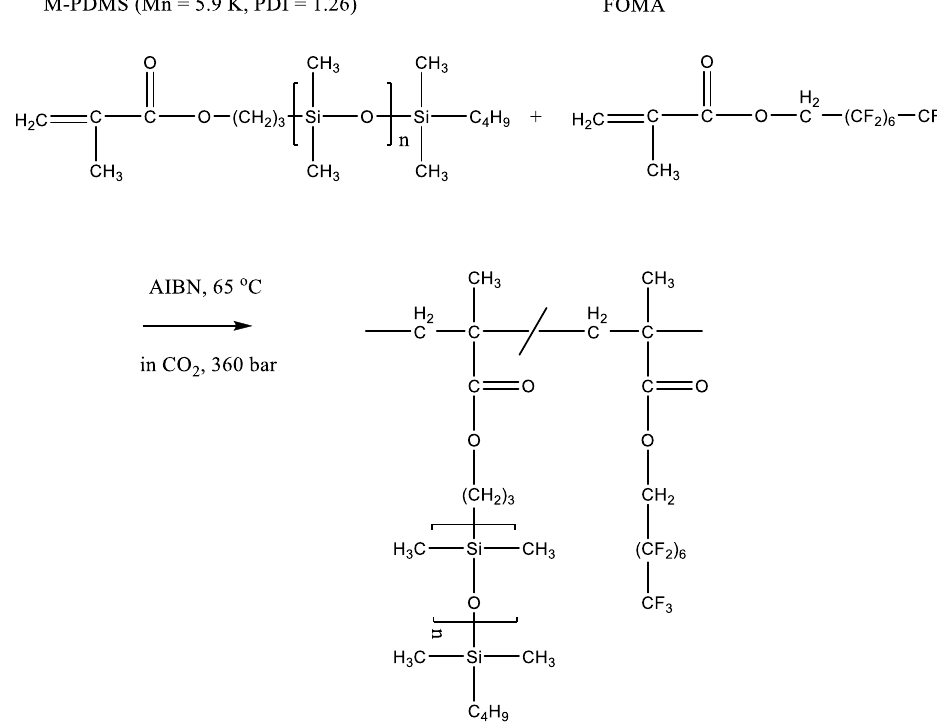
Figure 3. Copolymerization of PDMS and FOMA in supercritical CO 2 . Adopted from Ref.